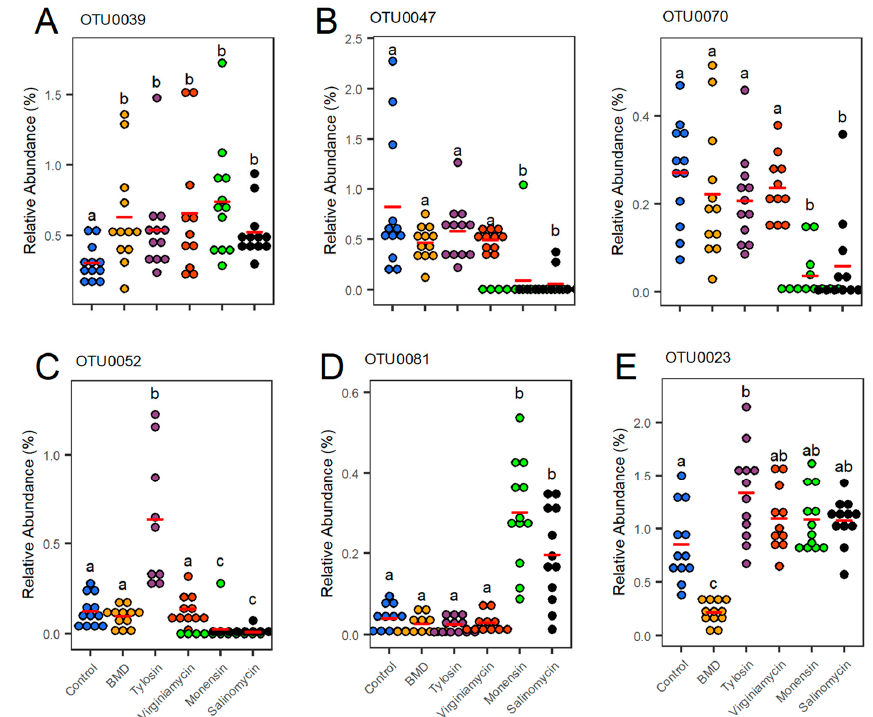
Figure 6. Differential regulation of representative bacteria taxa by in-feed antimicrobials. Each group consists of 12 cecal samples as indicated by each dot. The mean relative abundance of each group was indicated as a red dash. For OTU0052, three outliers (relative abundance > 3%) were omitted for better visualization of final differences among groups. Statistical significance was determined using Metastats [23], with the treatments not sharing a common letter considered significantly different ( p < 0.05).